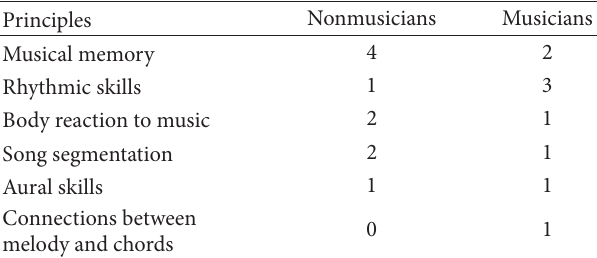
Table 9: Table of perceived principles upon which the application was designed.